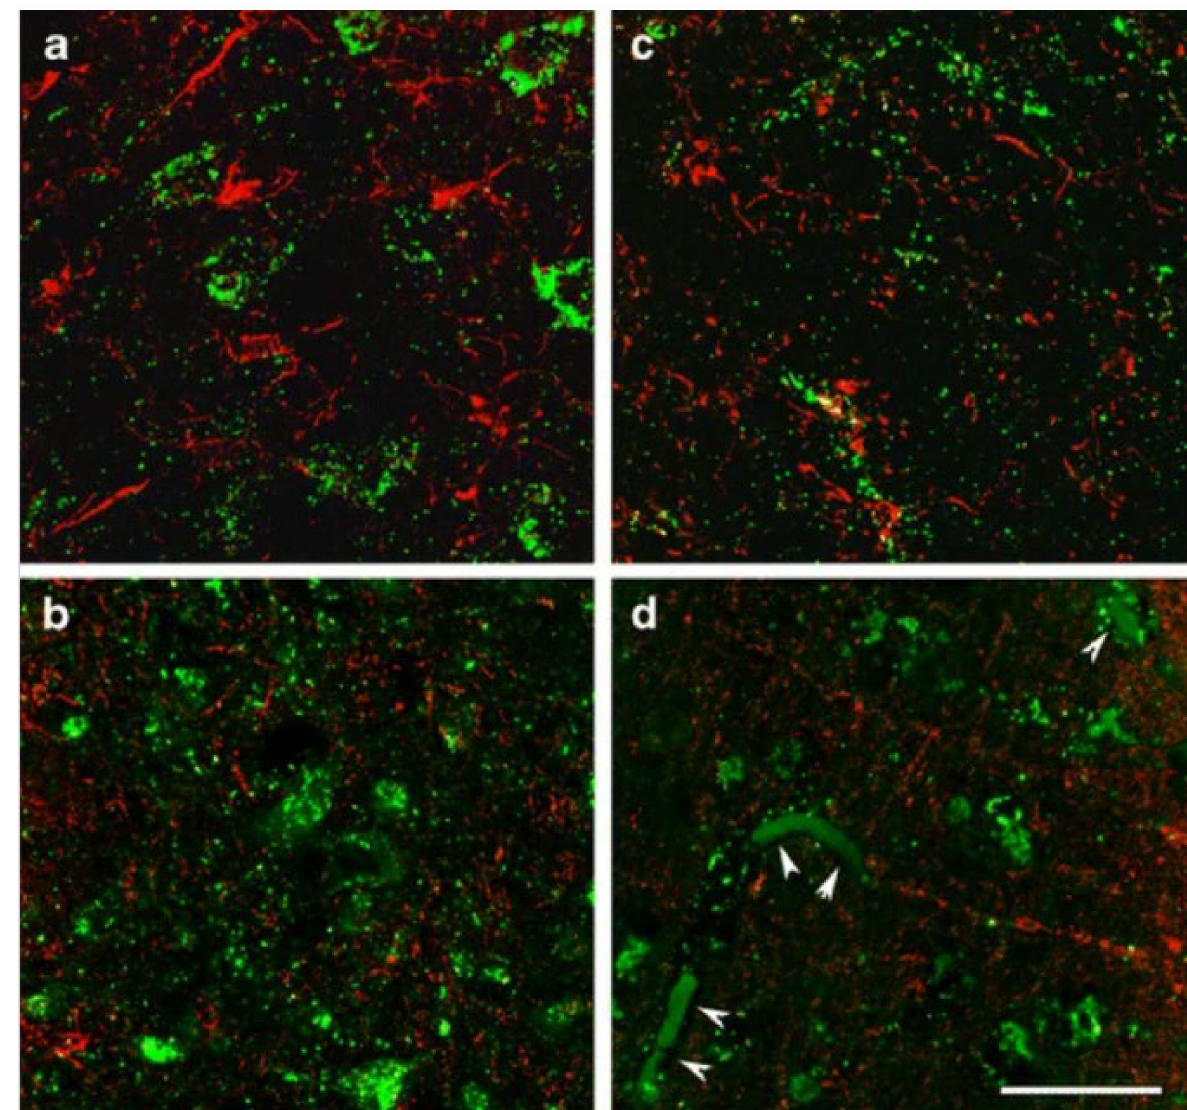
Figure 3. Immunohistochemistry of SUCLG2 and glial markers in the adult human brain. High magnification confocal images demonstrate that SUCLA2 immunoreactivity (green in ( a , b )) is present in neurons but not in Iba1-positive microglia cells (red in ( a )) and in oligodendroglial cells labelled with basic myelin protein (red in ( b )). In turn, SUCLG2 immunoreac- tivity (green in ( c , d )) does not co-localize with Iba1 (red microglia cells in ( c )) and cells labelled with basic myelin protein (red oligodendroglial cells in ( d )). The arrowheads in ( d ) point to red blood cells within vessels labelled non-specifically due to their internal peroxidase content. Scale bar=20 µ m. (Adapted from [99], by